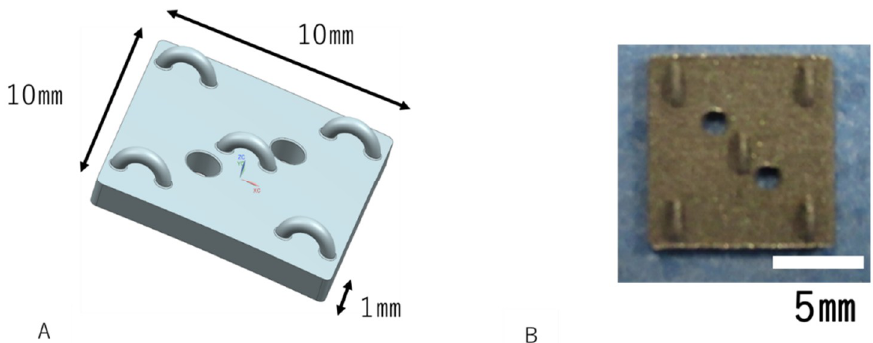
Figure 1. Shape of the Ti plates. ( A ): Designed plate. The dimensions of the AM Ti Plate samples are 10 mm × 10 mm × 1 mm. ( B ): Real image of an AM Ti Plate. The scale bar indicates 5 mm.